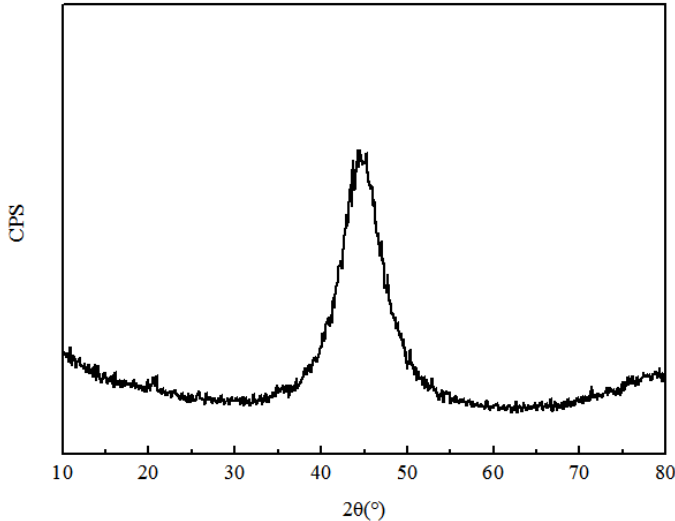
Figure 1. XRD curves of Fe80Si9B11 MG in composites rolled at initial temperature of 500 °C.